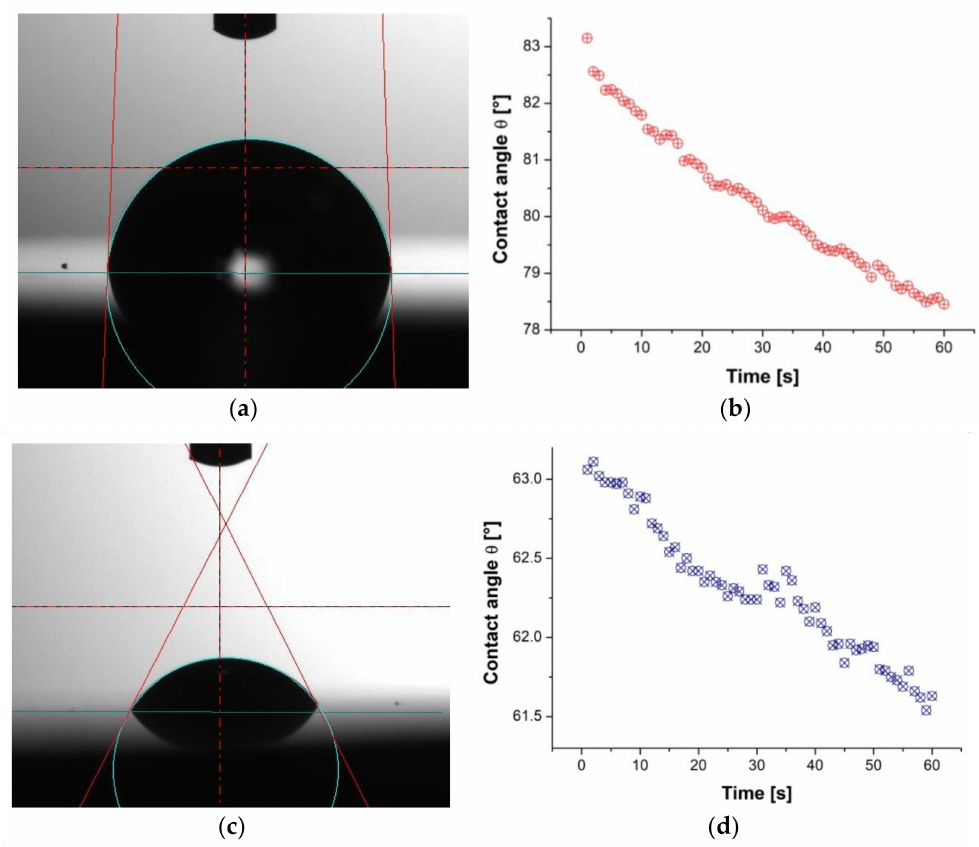
Figure 10. Results of contact angle measurements of the TiO 2 /nanoTiO 2 hybrid coating: ( a ) water drop, ( b ) contact angle value changes as a function of time for water, ( c ) diiodomethane drop, and ( d ) contact angle value changes as a function of time for